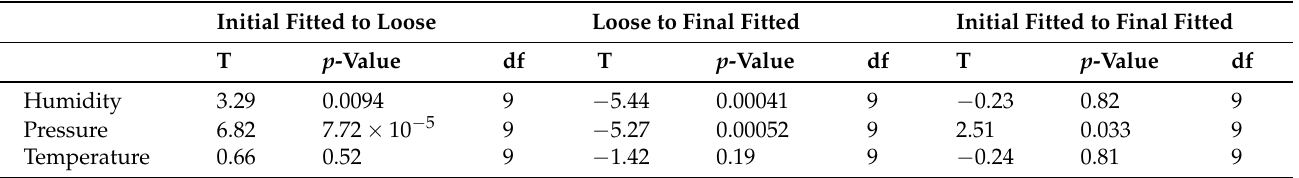
Figure 19. Peak to peak values of temperature as a function of fitting condition. Table 1. Two-sided paired t-test performed on fitting condition data